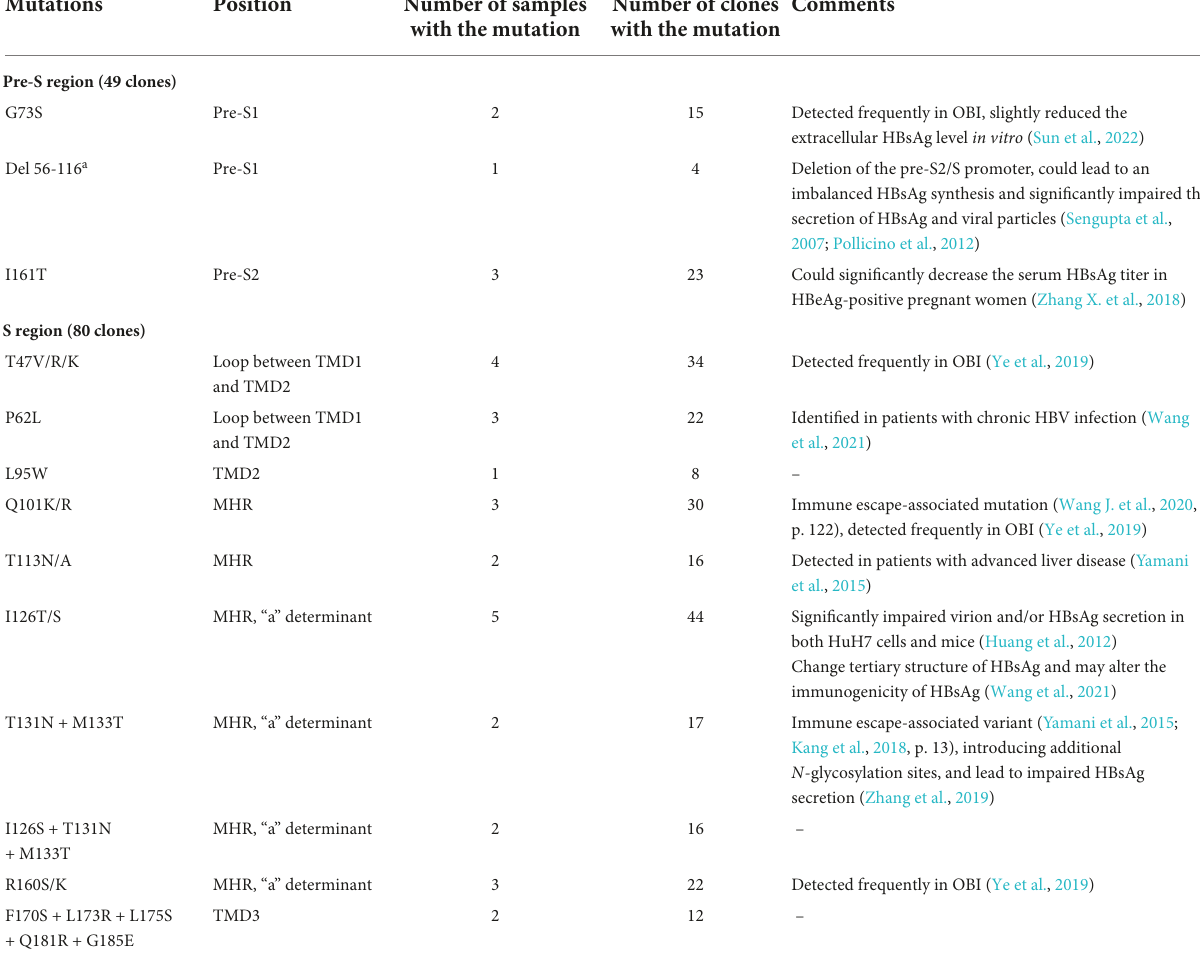
TABLE 4 Summary of common viral mutations in six HBsAg-/anti-HBs+/HBeAg+ samples of genotype C. Mutations Number of samples with the